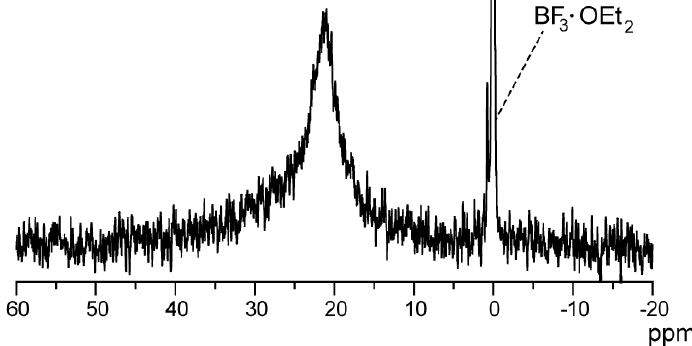
Figure 3. 11 B-NMR spectrum of poly(NIPAAm- block -NIPAAm- co -PBA) in DMSO-d 6 solvent at ambient temperature. BF 3 ·OEt 2 was adopted as the internal reference.